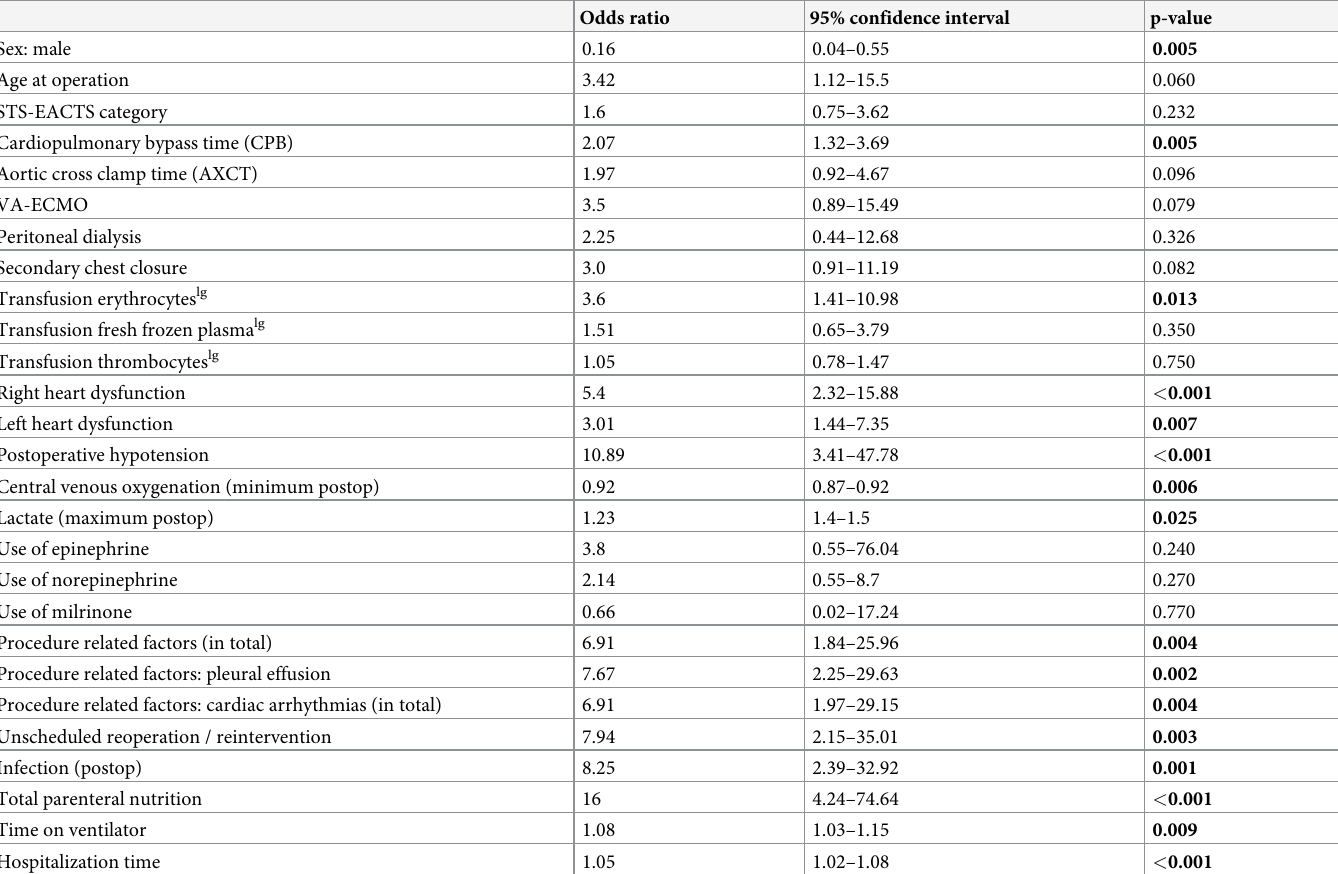
Table 2. Bivariate risk factor analysis.